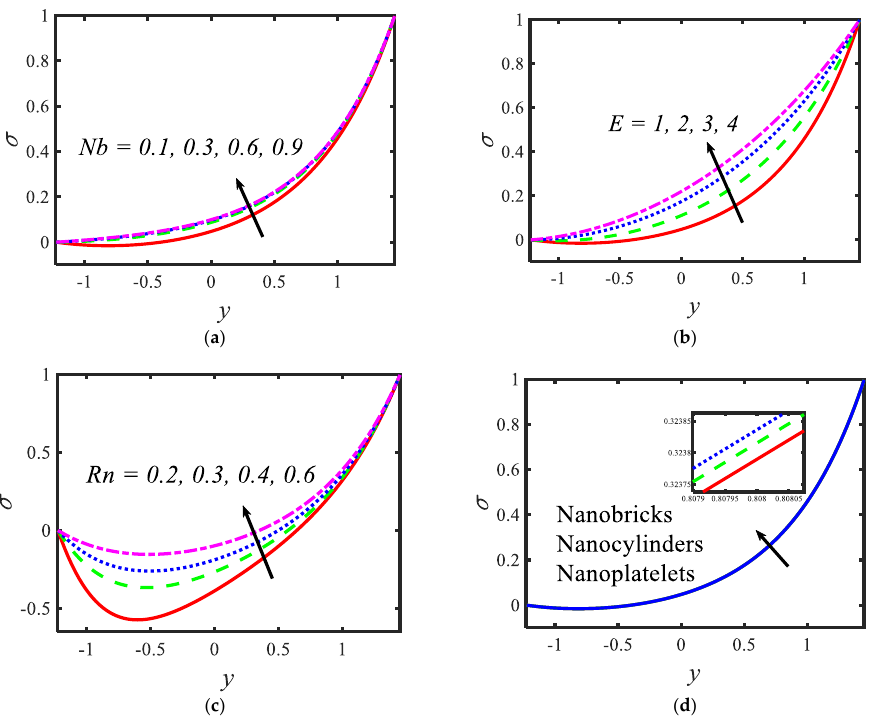
Figure 5. Variations in nanoparticle volume fraction profiles for ( a ) the Brownian motion parameter, ( b ) activation energy parameter, ( c ) radiation parameter and ( d ) the Shape factor. Micromachines 2022 , 13 , x FOR PEER REVIEW Figure 6 is plotted to judge the variation of microorganism concentrations for various parameters, such as activation energy parameter 𝐸 , temperature ratio parameter 𝛽 , Peclet